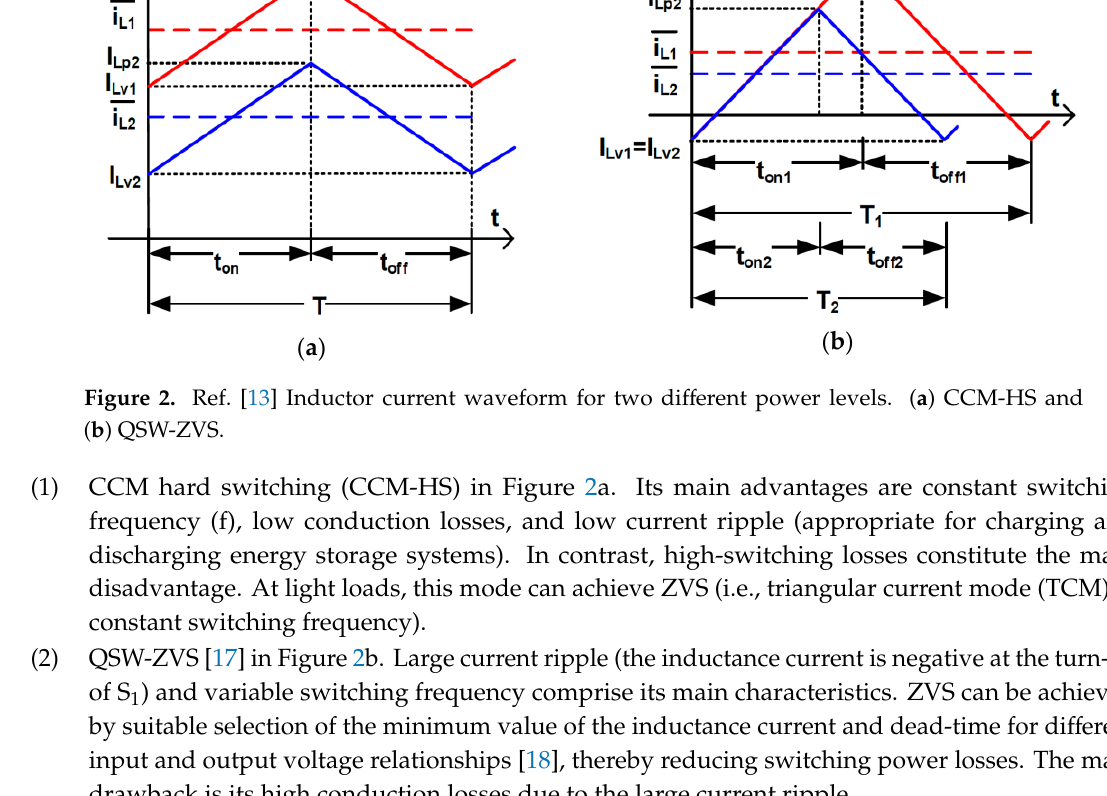
Figure 2. Ref. [13] Inductor current waveform for two different power levels. ( a ) CCM-HS and ( b ) QSW-ZVS.